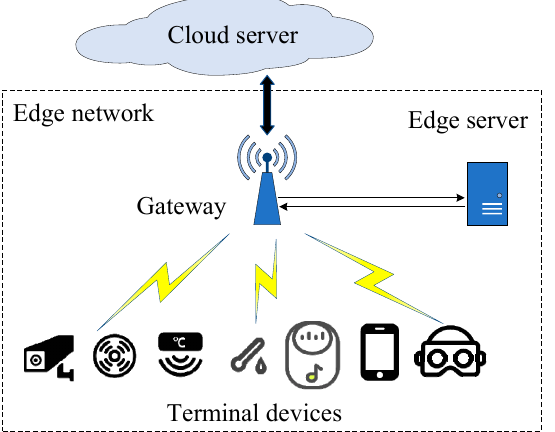
Figure 3. The architecture of